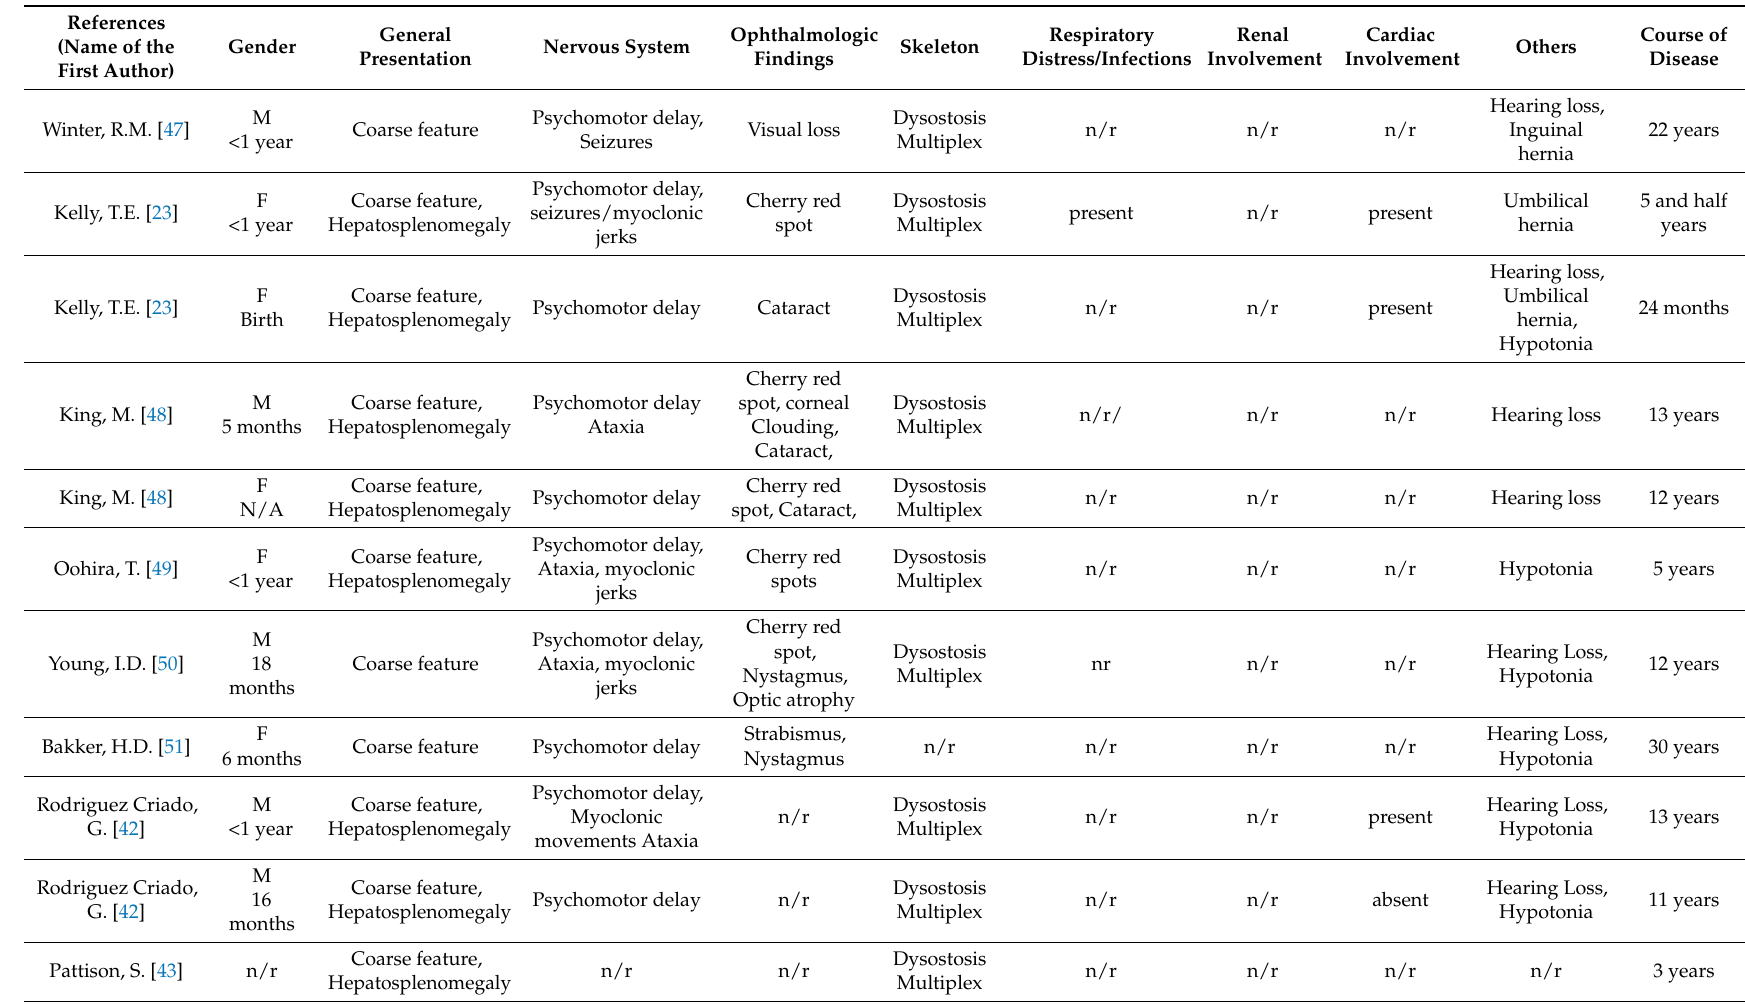
Table 2. Clinical and Morphological findings of patients suffering from sialidosis II, subtype infantile/Juvenile form (Cases from 1980 until the date of submission are included). M = male; F = female; n/a = not available n/r = not reported; no = not detected; ECG = electrocardiogram; ** Authors reported the case “suspected as sialidosis II” after other congenital errors of metabolism investigated during her childhood, such as mucopolysaccharidosis, were excluded. No formal genomic testing is reported in the